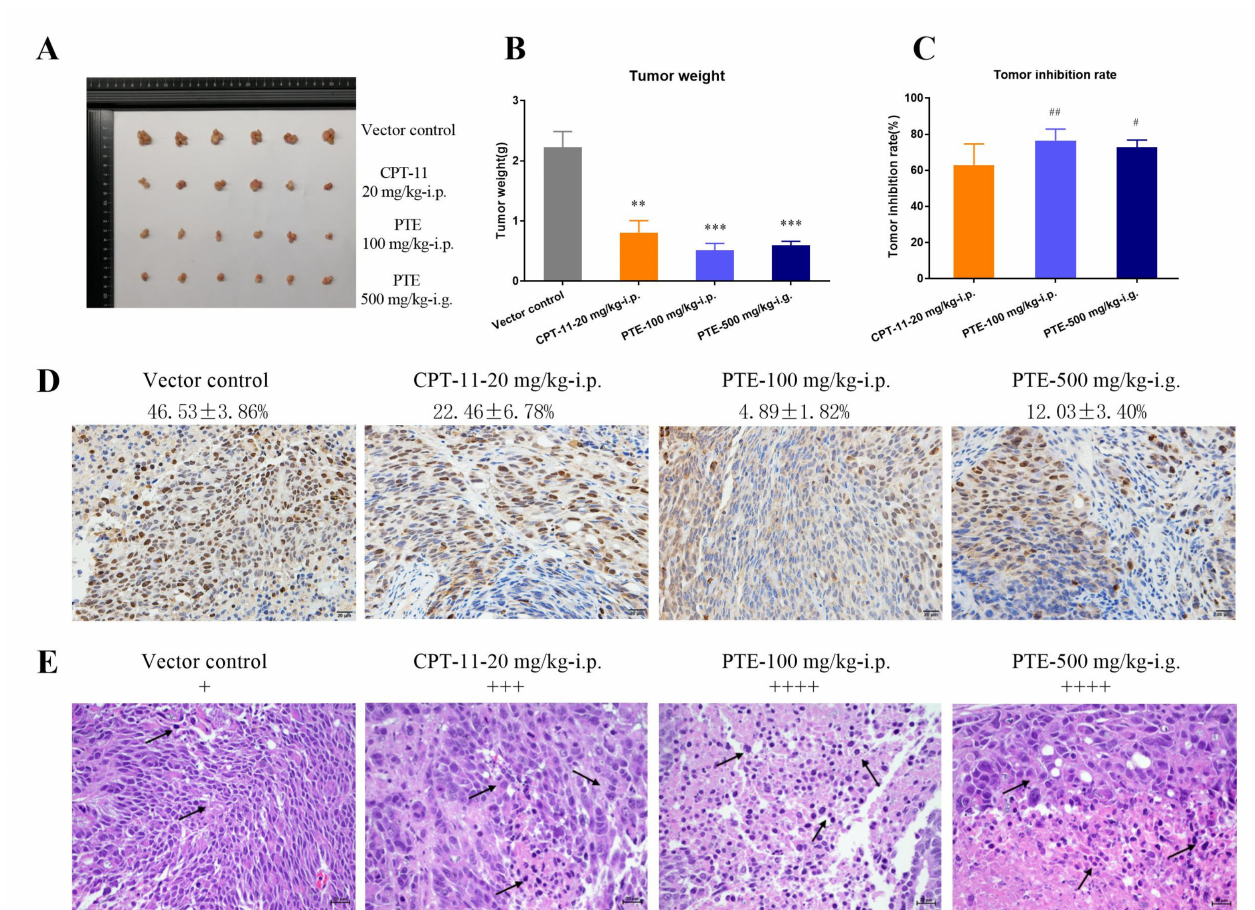
Figure 9. Inhibitory effect of PTE on tumor growth in orthotopic CL187 xenograft nude mice. ( A ) Photograph of dissected tumor tissue. ( B ) Tumor weight. ( C ) Tumor inhibition rate. ** p < 0.01, and *** p < 0.001 vs. vector control. # p < 0.05, and ## p < 0.01 vs. CPT-11 group. ns, not significant. Data are mean ± SD, n = 6. ( D ) Immunohistochemical analysis of Ki67 staining for tumors; the scale bar represents 20 µ m. The yellow cells are those labeled IKi67. ( E ) HE assays for tumors; the scale bar represents 20 µ m. The degree of tumor necrosis was expressed as +, and + represents the ratio of tumor necrosis area to total tumor tissue <1/4; ++ indicates the ratio was between 1/4 and 1/2; +++ denotes the ratio between 1/2 and 3/4, and ++++ indicate the ratio >3/4. The areas indicated by the black arrow are apoptotic cells and inflammatory cells in the tumor necrotic